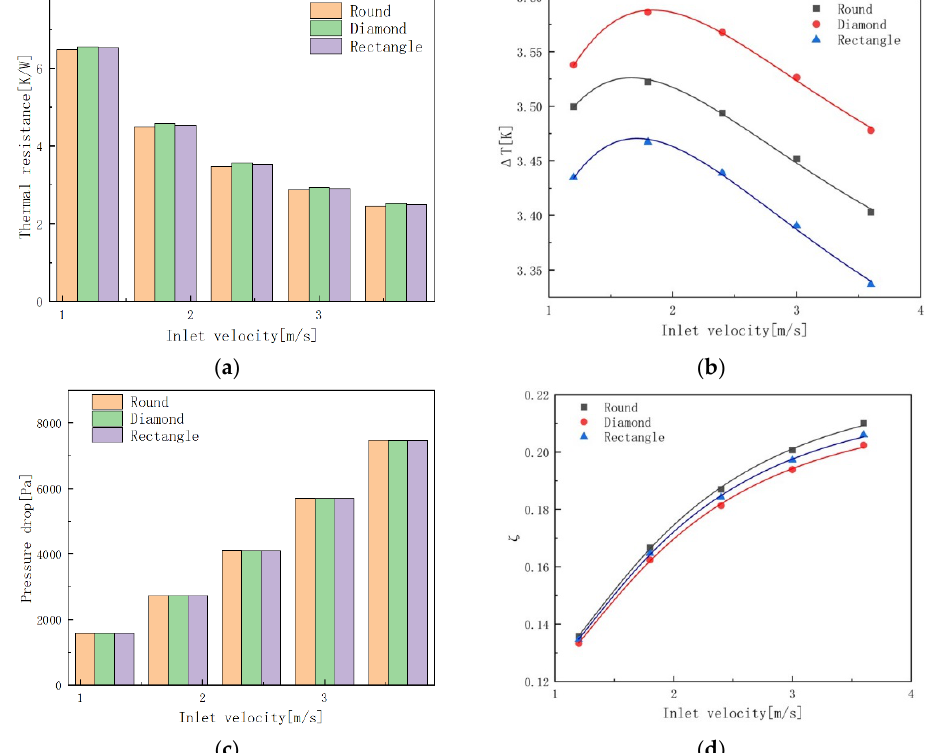
Figure 10. Flow and heat transfer characteristics of the double-layer MMC with different pin–fin shapes: ( a ) thermal resistance; ( b ) maximum temperature difference; ( c ) pressure drops; and ( d ) comprehensive performance.